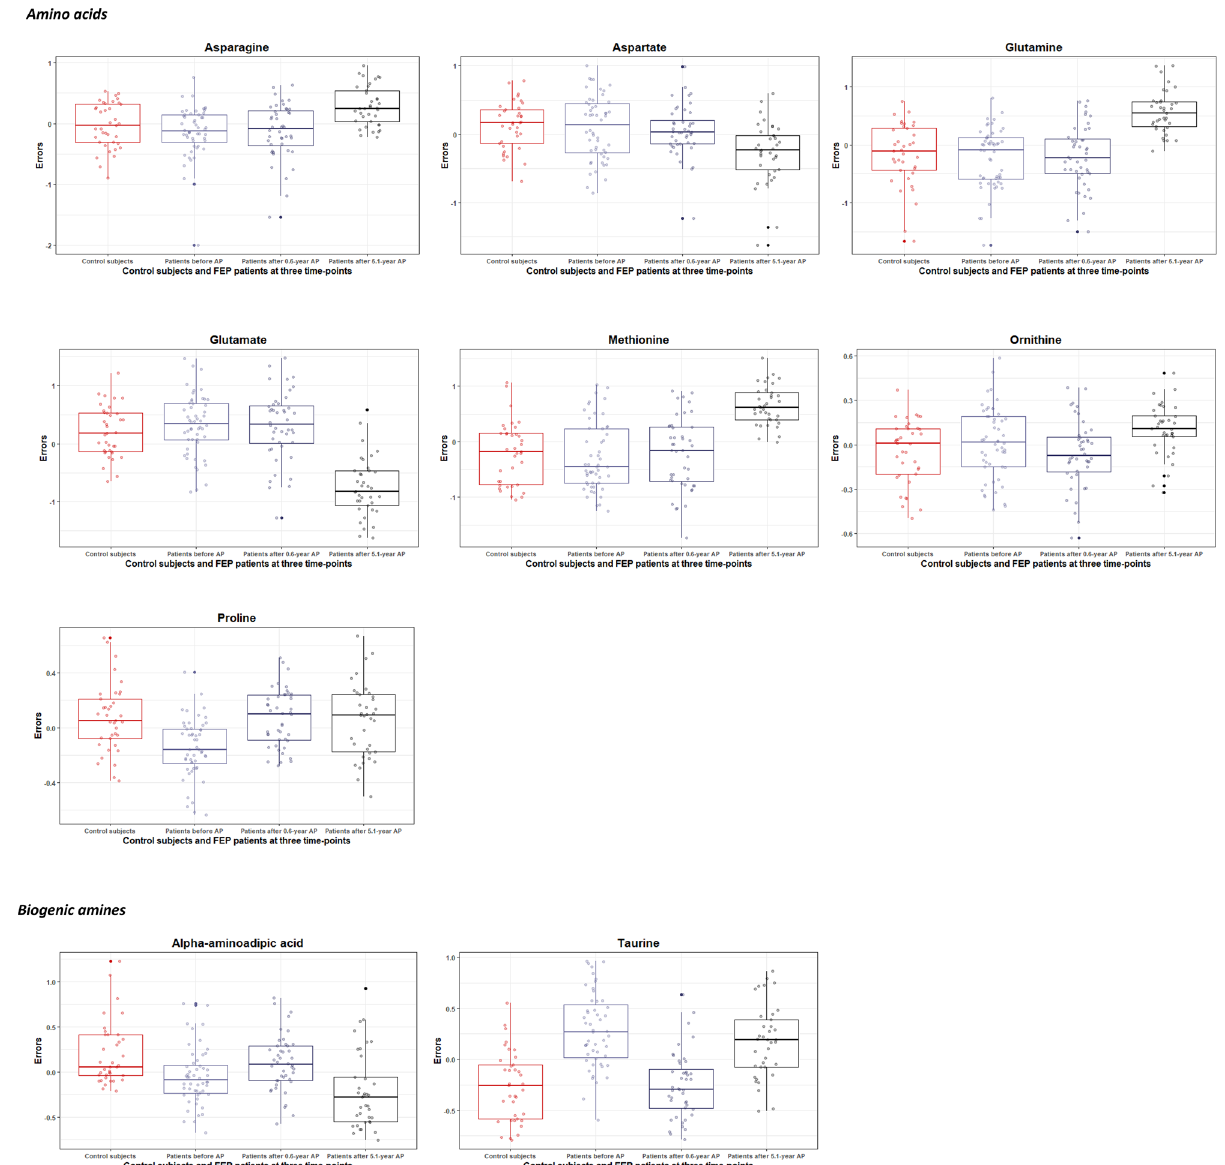
line represents the 50th to the 75th and the 25th to the 50th percentiles, respectively. The whiskers extend to the highest and lowest values contained within 1.5 times the interquartile range of the data. Each calculated error variance is represented as a